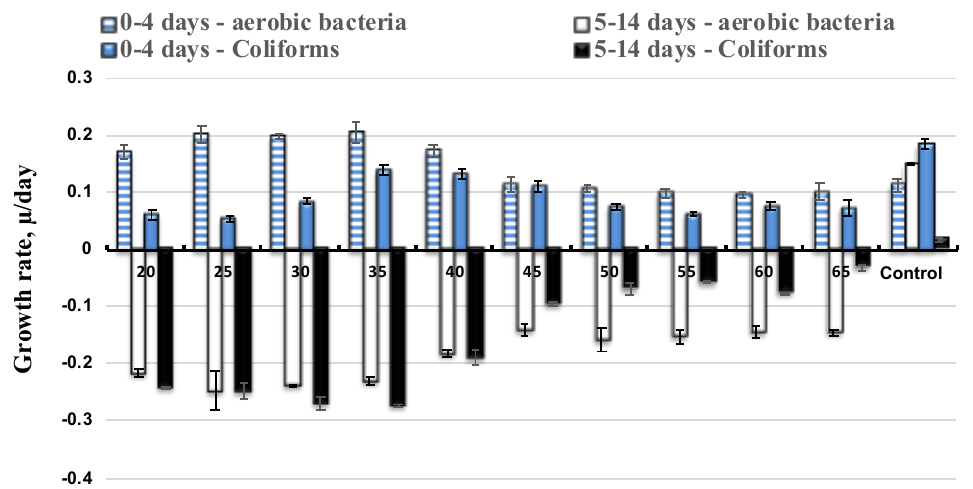
Figure 2. Growth rate of bacteria population function to initial Chlorella vulgaris cell density following two period times of culture: (1) 0–4 days of culture and (2) 5–14 days of culture.